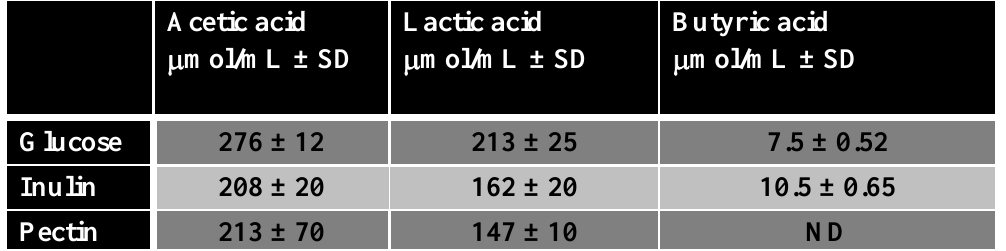
Table 1. L. plantarum subsp. plantarum production of lactic, acetic and butyric acid during growth in the presence of 20 g/L of glucose, pectin or inulin The data are expressed as μ moles/mL (n = 3), ND: not detectable. For the details, see materials and